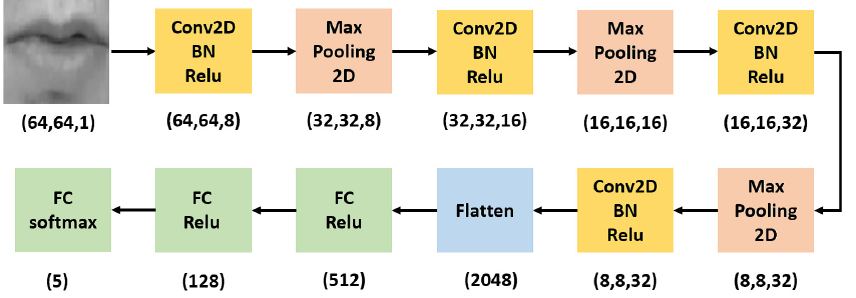
Figure 2. A 2D CNN model for view classification. Numbers in parentheses mean data shapes. For example, (64,64,1) indicates 64